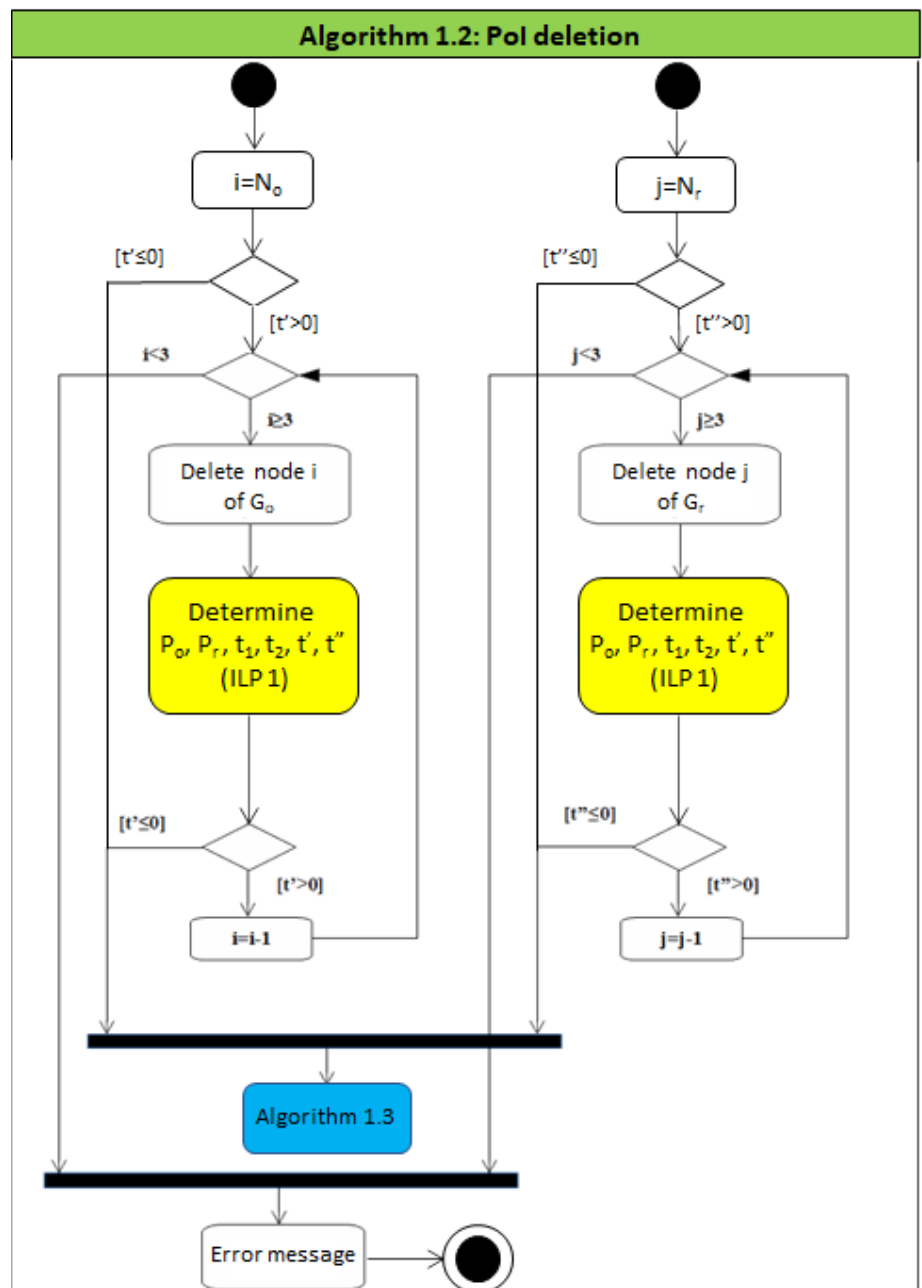
Figure 4. The UML diagram for the node deletion